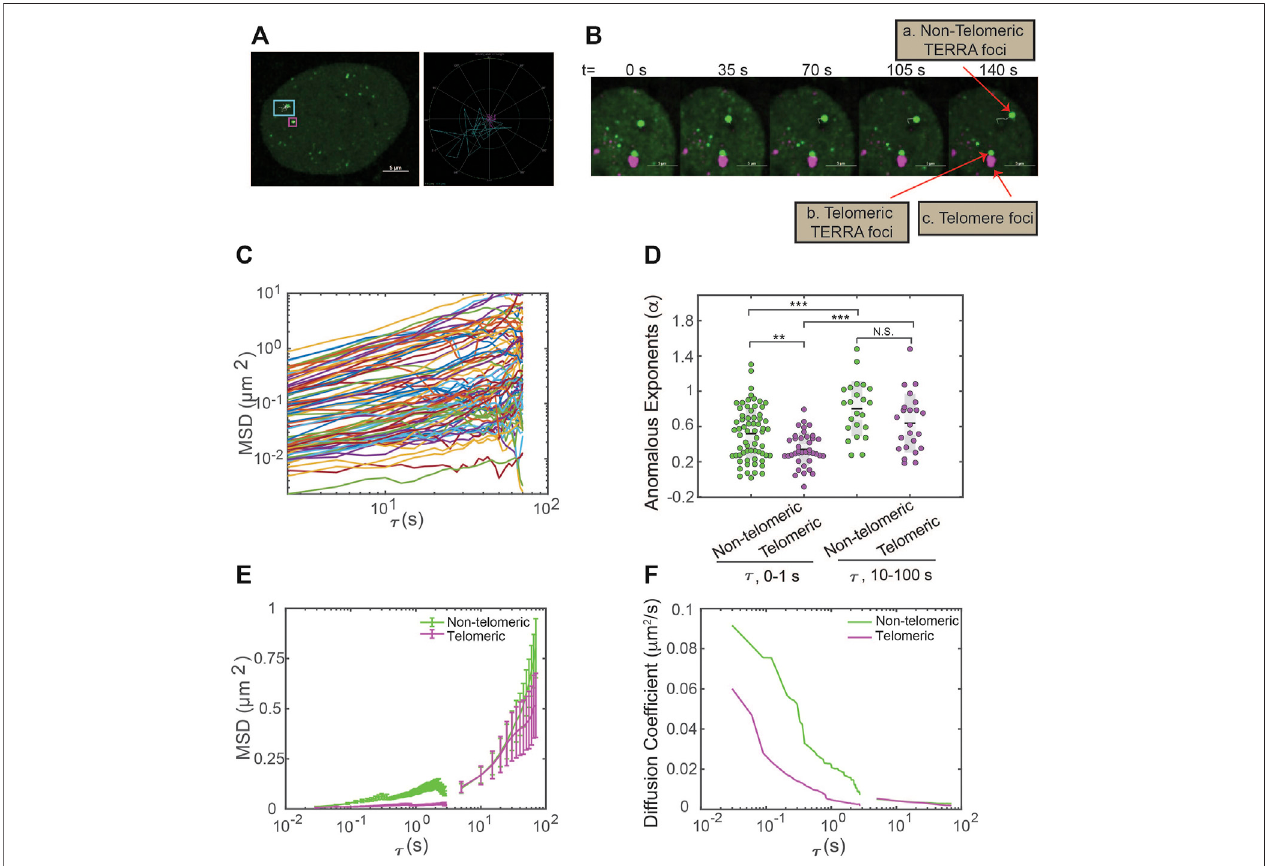
FIGURE 3 | Single-particle tracking of TERRA foci mobility in live cells. (A) Left, U2OS cells expressing dCas13b-SunTag-sfGFP with an overlay of representative TERRA foci tracks. Right, trajectories of the TERRA foci highlight the areas explored by the two selected TERRA foci in the left image. (B) Time-series images showing a representative TERRA focus (a) that is not localized to telomeres (called non-telomeric) and a TERRA focus (b) whose motions are in tandem with the neighboring telomere foci (c) and so is taken to be colocalized with the telomere (called telomeric). (C) Representative Mean Square Displacement (MSD) trajectories plotted versus lag time ( τ ) on log-log coordinates for TERRA foci. Each line represents one TERRA track. (D) The anomalous exponents evaluated from the MSD plots on two timescales 0 – 1 s and 10 – 100 s for telomeric and non-telomeric TERRA foci, each dot represents one TERRA track. * p < 0.05, ** p < 0.01, and *** p < 0.001. (E) MSDs averaged at each τ for telomeric and non-telomeric TERRA foci. (F) Time-dependent diffusion coef fi cients evaluated from the average MSD plots for telomeric and non- telomeric TERRA foci over lag time τ .